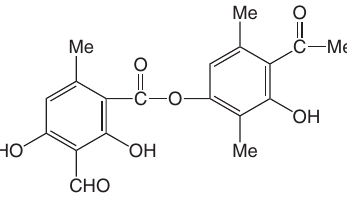
FIGURE 1 - Chemical structure of